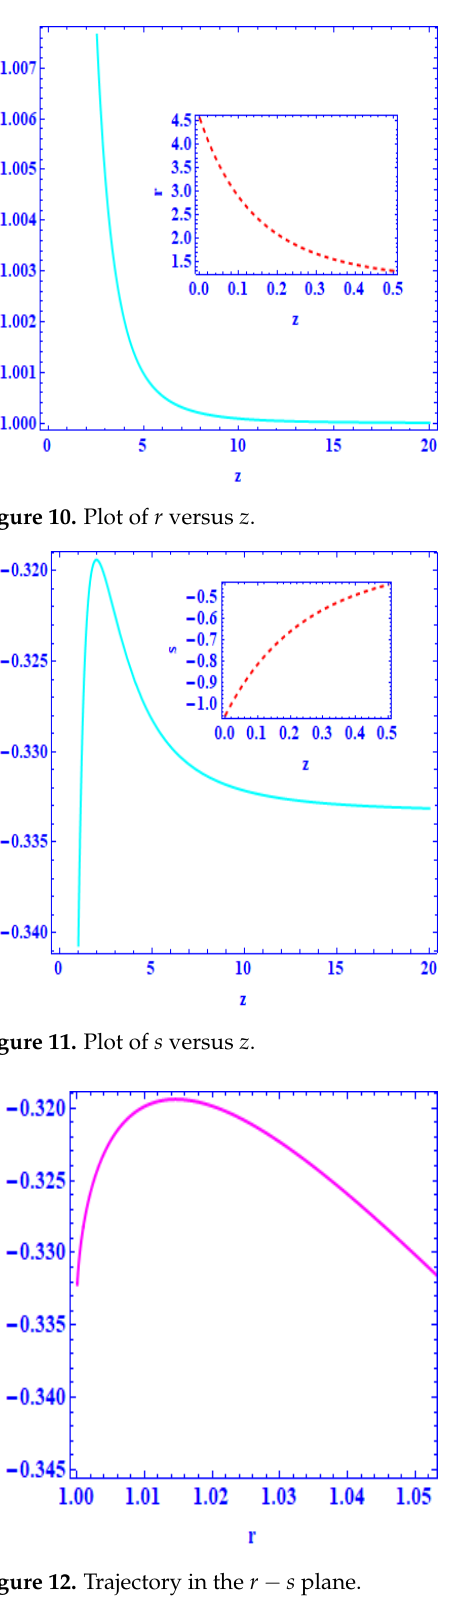
Figure 12. Trajectory in the r − s